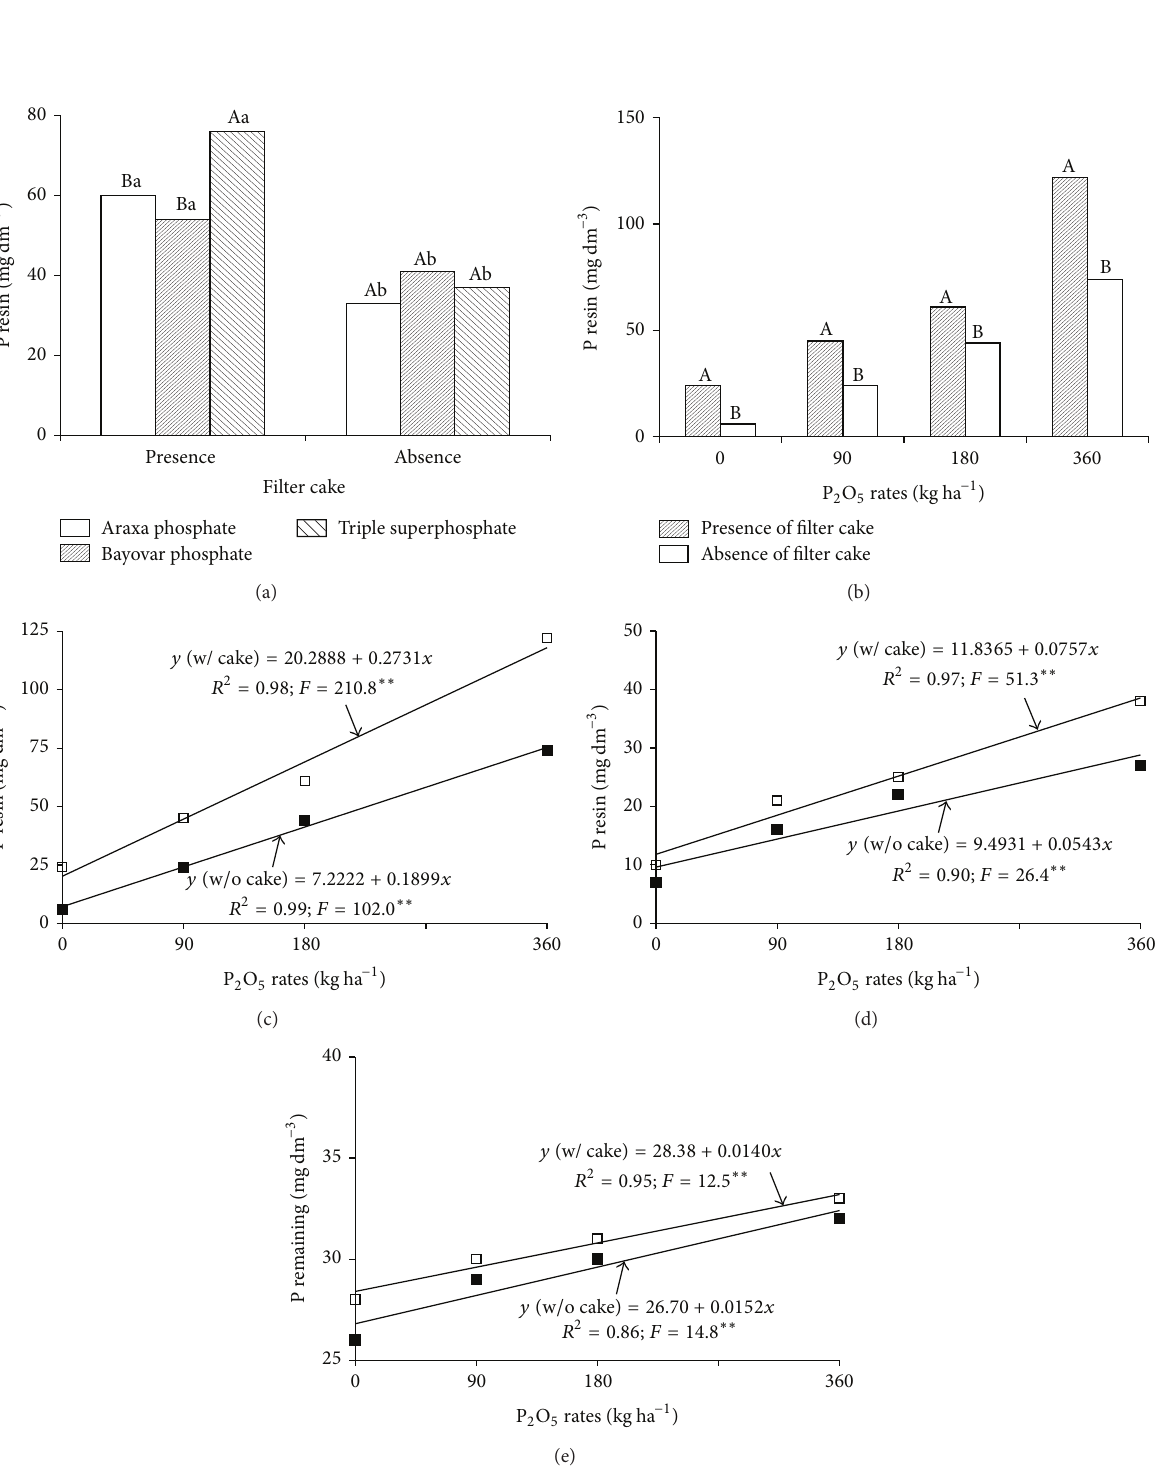
Figure2:Availablephosphorus(Presin)inthesoilat0.0–0.2